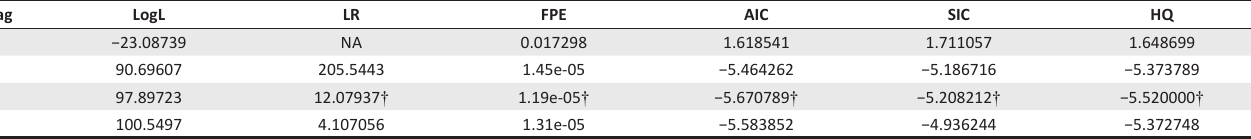
TABLE 3: Optimum lag length selection.